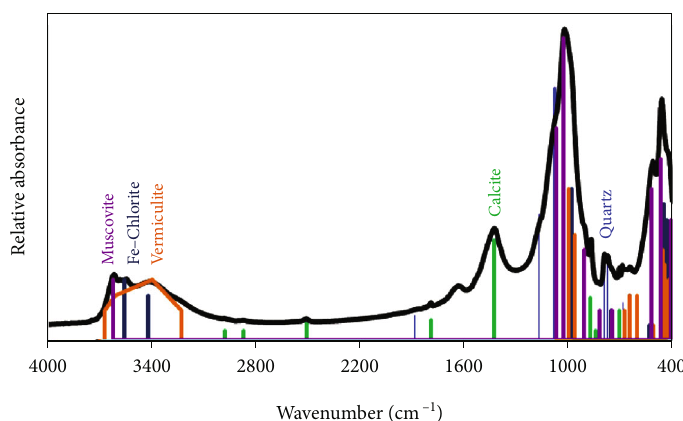
Figure 2: FTIR spectra of the TKC